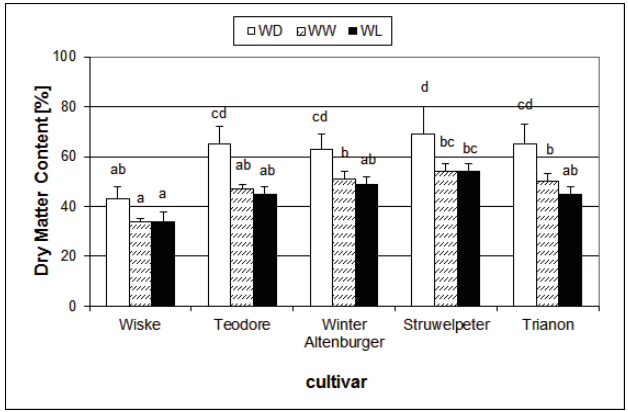
Fig. 2: Dry matter content [%] of different cultivars and varieties of Lac- tuca sativa spp. grown under different water regimes (water-deficit = 18-25 % [WD], well-watered = 50 % [WW], water-logged = 61- 70 % [WL]). Data represent n ± SD. Bars with different letters were significantly different (Tukey-B test, p ≤ 0.05).